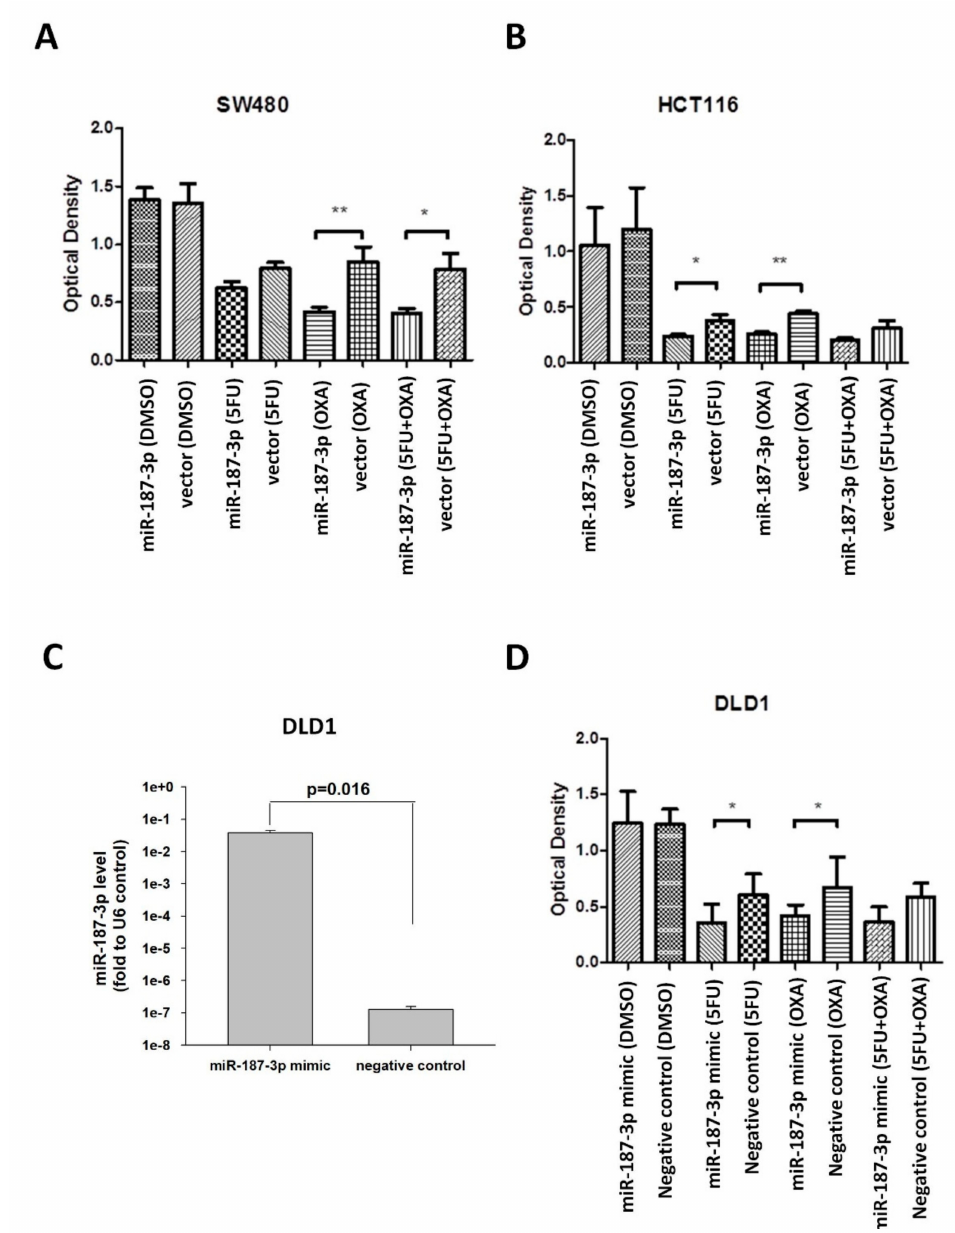
Figure 3. MiR-187-3p overexpression induced response of CRC cells to chemotherapeutic drugs: MTT assay was performed to determine the effect of 72 h treatment with vehicle control (DMSO), 5-fluorouracil (5-FU), oxaliplatin (OXA), or combined 5-FU + OXA on ( A ) stable HCT116-miR-139-3p or control vector cells, ( B ) stable HCT116-miR-139-3p or control vector cells, and ( C ) DLD1 transiently overexpressed miR-187-3p mimic or negative control cells. The left panel shows the miR-187-3p levels in the transfected cells as determined by quantitative PCR. ( D ) The optical density in terms of absorbance at 570 nm was determined after 72 h drug or vehicle treatment. All experiments were per- formed in triplicate, and the data are expressed as the mean ± SEM of three independent experiments; * and ** indicate that the difference is statistically significant ( p < 0.05 and p < 0.01,